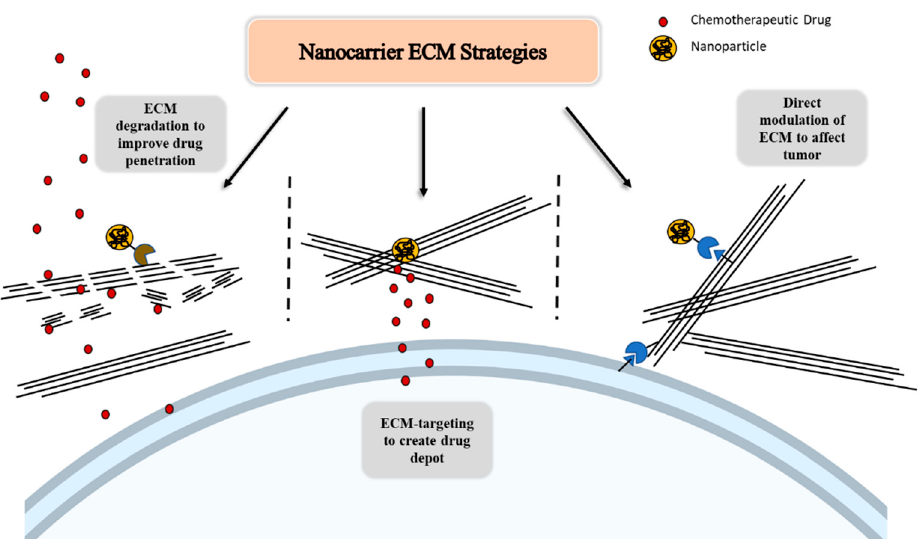
Figure 2. Schematic of extracellular matrix (ECM)-based strategies to improve drug delivery and modulate tumor growth and invasion, with the aid of nanoparticles, through ECM degradation to improve drug delivery, ECM-targeting to create a local drug depot, and direct modulation of the ECM.